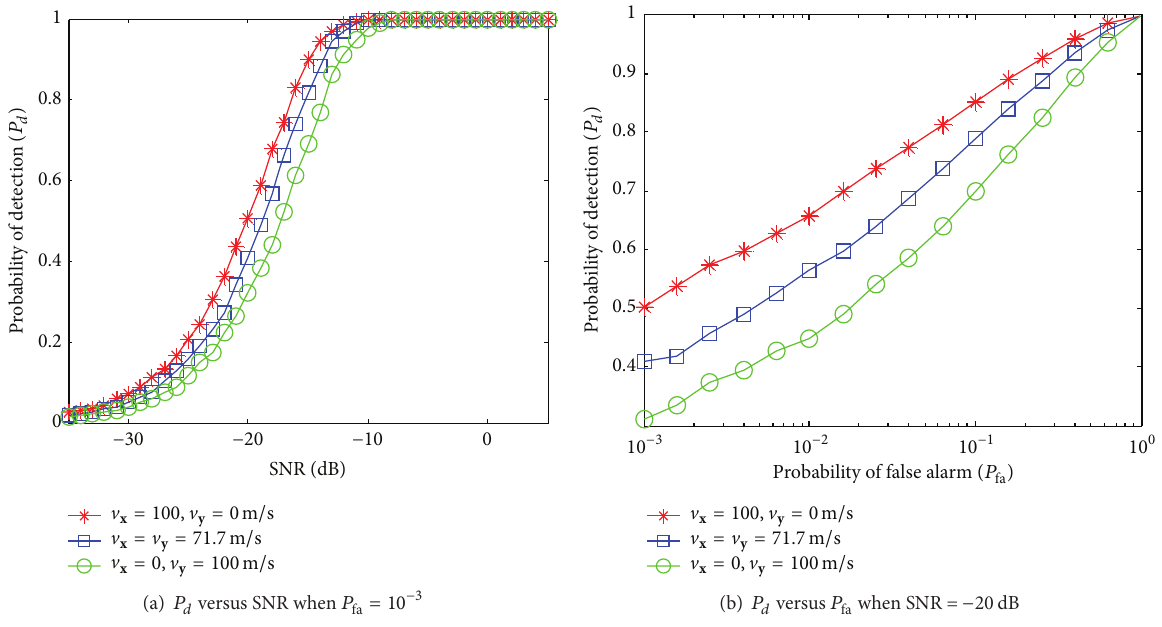
Figure 8: Effect of different directions of target velocity on detection performance.